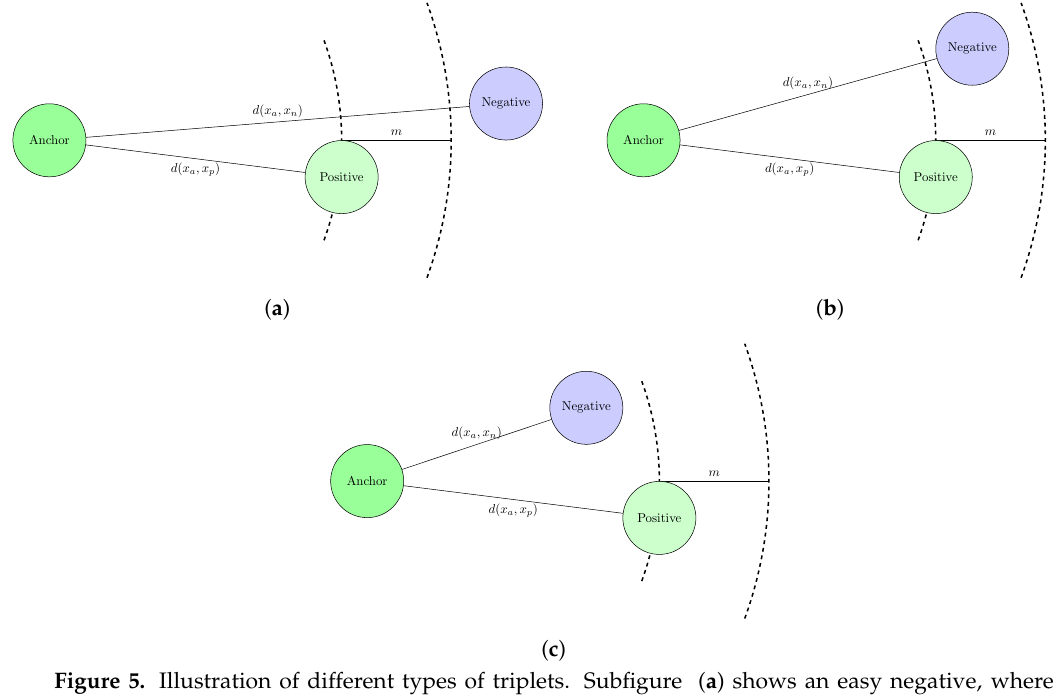
Figure 5. Illustration of different types of triplets. Subfigure ( a ) shows an easy negative, where d ( x a , x n ) > d ( x a , x p ) + m , resulting in zero loss. Subfigure ( b ) illustrates a semi-hard negative, as d ( x a , x p ) < d ( x a , x n ) < d ( x a , x p ) + m , resulting in a positive loss. On subfigure ( c ), the so-called